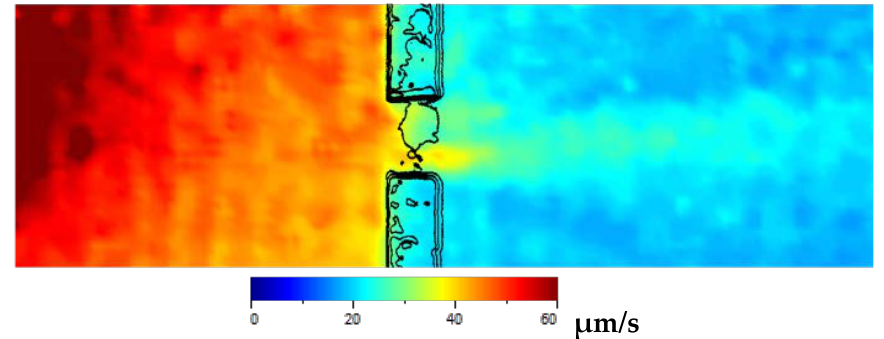
Figure 13. 100–500 kHz swept sine wave excitation out-of-plane RMS plot with an outline of the C-Scan over laid. Note the reduction in wave energy surrounding the PTFE tape region causing a reduction in high amplitude waves transmitting through the disbonded region.